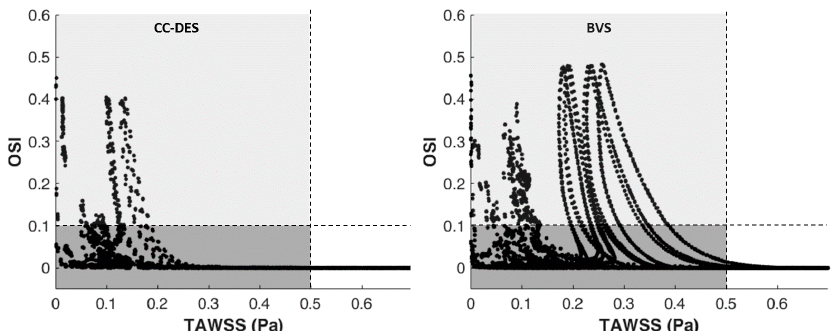
Figure 13. OSI vs. TAWSS plots. Each point represents a nodal solution of the arterial wall. The considered configurations were OD = 200, 2500, 3000, 3500 and 4000 µm for both stent